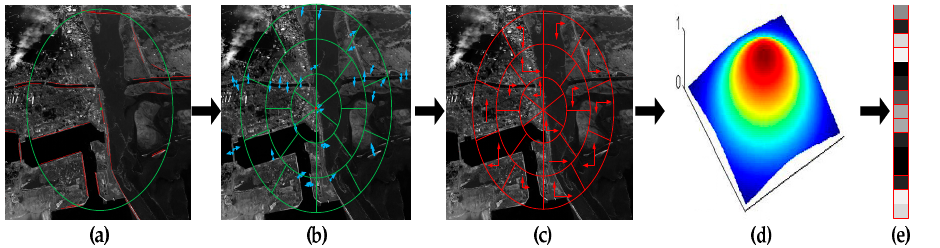
Figure 8. Generation process of the proposed descriptor. ( a ) An image taken after a tsunami with the extracted line segments; ( b ) the proposed histogram binning strategy used on a line segment and a number of blue arrows representing the orientation of the other line segments; ( c ) descriptor computation; ( d ) Gaussian weighting function; ( e ) descriptor vector generation.